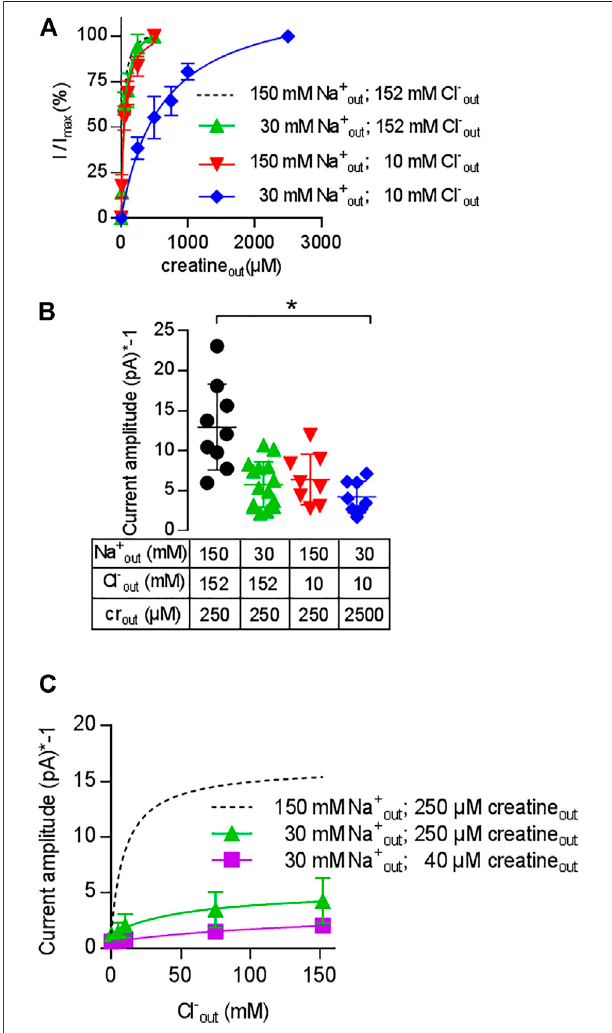
FIGURE 6 | Cooperativity of creatine, sodium and chloride. A&B: Change in the EC 50 of creatine (A) and in current amplitude (B) resulting from reduction in the concentration of co-substrate ions: transport-associated currents were elicited by superfusing HEK293 cells transiently expressing CRT-1 with an external solution containing increasing concentrations of creatine and 30 mM Na + and 152 mM Cl − (green upward triangles), 152 mM Na + and 10 mM Cl − (red downward triangles) or 30 mM Na + and 10 mM Cl − (blue diamonds). In panel A, the current amplitude (I) at each creatine concentration was normalized to the amplitude observed at the highest creatine concentration (I max , recorded at 250 µM or 2.5 mM creatine for the triangles and diamonds, respectively). The solid lines were drawn by fi tting the data to the equation for a rectangular hyperbola. EC 50 -values were estimated as 47.2 ± 5.0 µM (low Na + = 30 mM Na + and 152 mM Cl − ), 40.1 ± 6.4 µM (low Cl − = 152 mM Na + and 10 mM Cl − ) and 609.9 ± 63.5 µM (low NaCl = 30 mM Na + and 10 mM Cl − ). Data are means ± S.D. from 6, 8 and 8 independent recordings for low Na + (= 30 mM Na + and 152 mM Cl − ), low Cl − (=152 mM Na + and 10 mM Cl − ) and low NaCl (= 30 mM Na + and 10 mM Cl − ) respectively. For the sake of comparison, the dashed line shows the concentration-response curve from Figure 1C , which was obtained in the presence of 152 mM external NaCl. Panel B shows the current amplitudes obtainedatthemaximumconcentrationsofcreatine(i.e.250µMor2.5 mMas indicated) and at the ionic conditions employed in panel A; current amplitudes